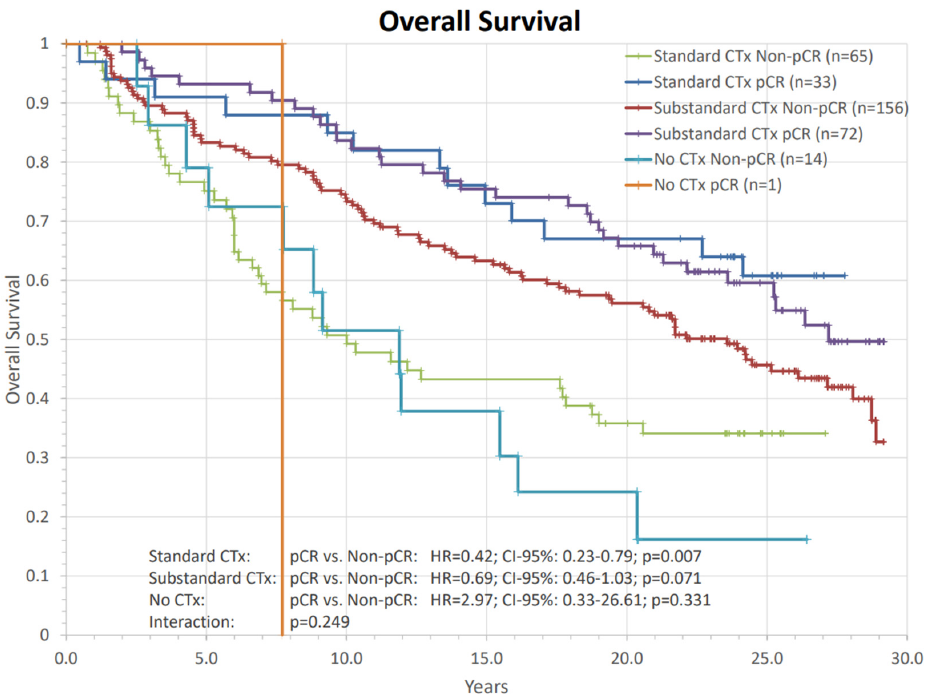
Figure 7. Analysis of the impact of pathological complete response (pCR) on overall survival between different preoperative chemotherapy regimens. The comparisons are presented with hazard ratios and their corresponding confidence intervals and p -values. HR: hazard ratio, CTx: chemotherapy, CI: confidence interval, pCR: pathological complete response, n: number of patients.